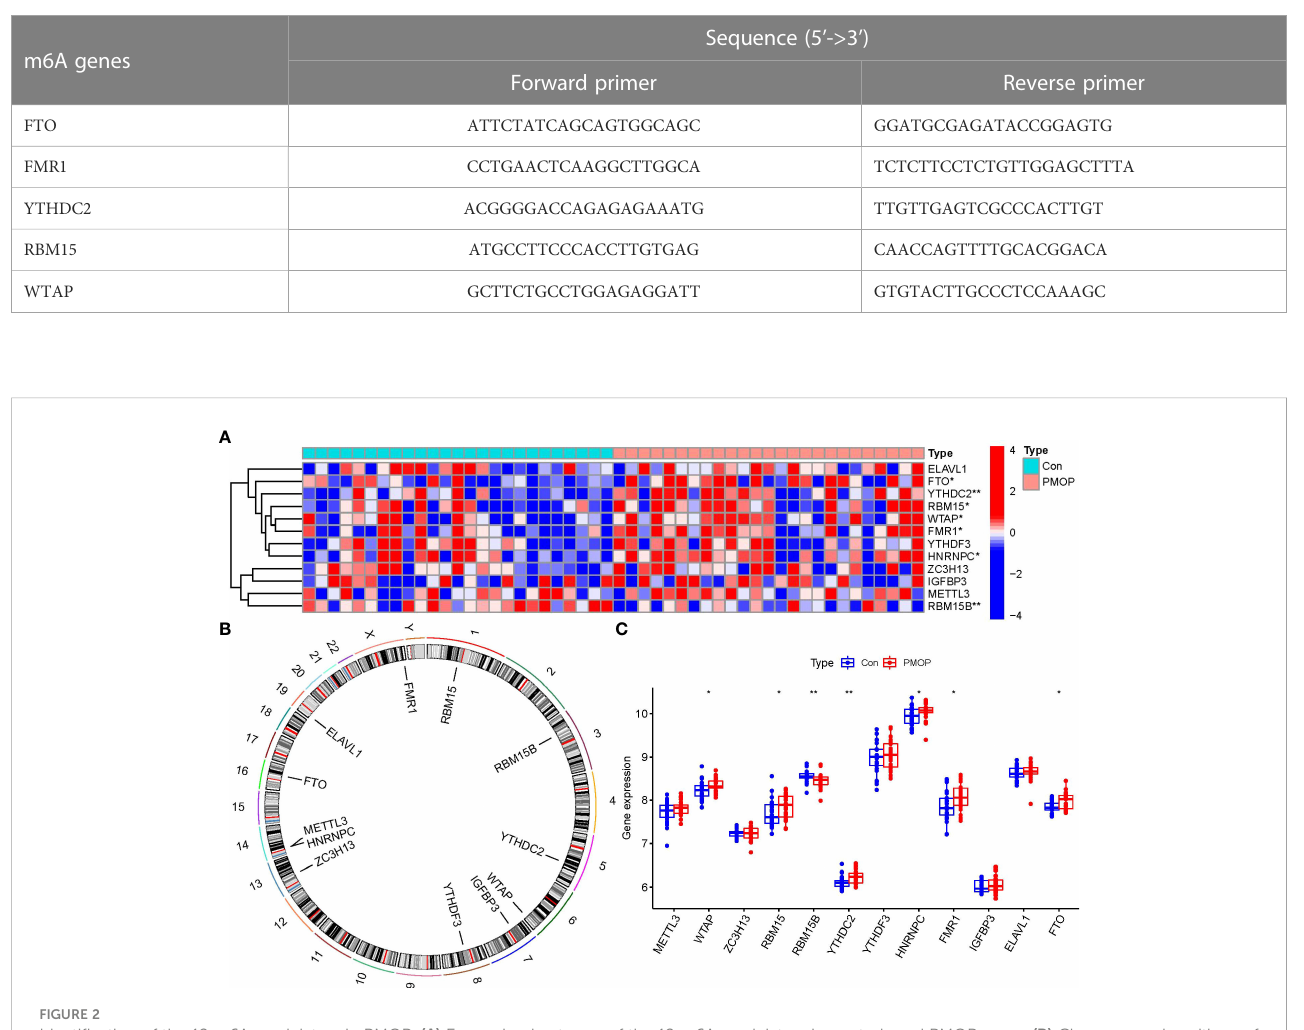
FIGURE 2 Identi fi cation of the 12 m6A modulators in PMOP. (A) Expression heat map of the 12 m6A modulators in controls and PMOP cases. (B) Chromosomal positions of the 12 m6A modulators. (C) Differential expression boxplots of the 12 m6A modulators between controls and PMOP cases. *p < 0.05, and **p <